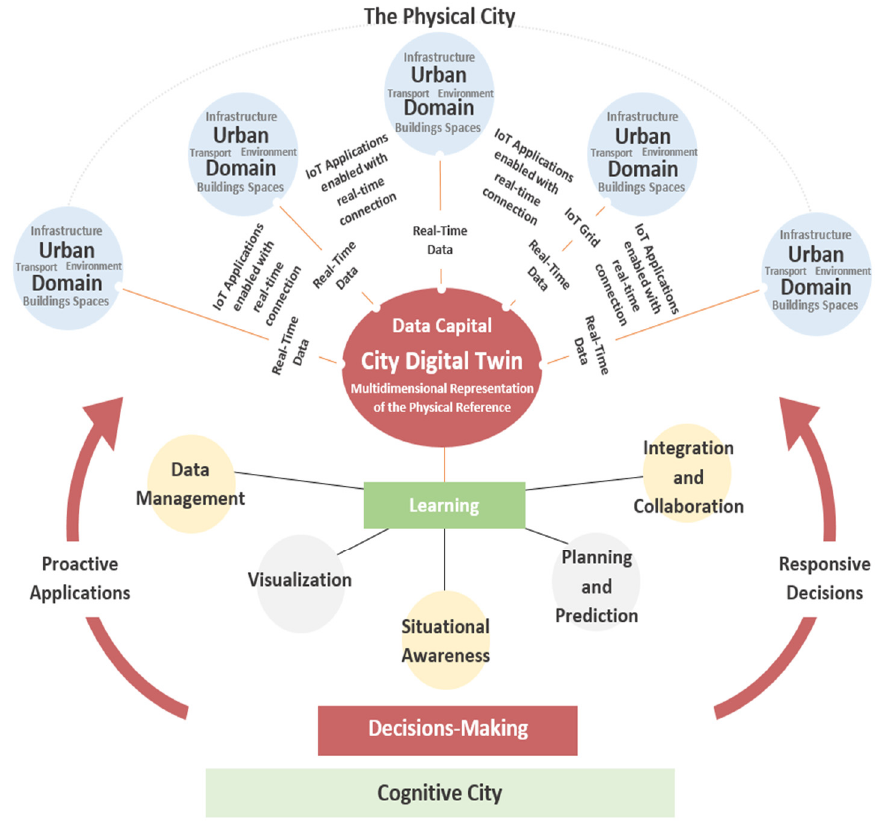
Figure 8. City digital twin mechanism. Source: Authors.